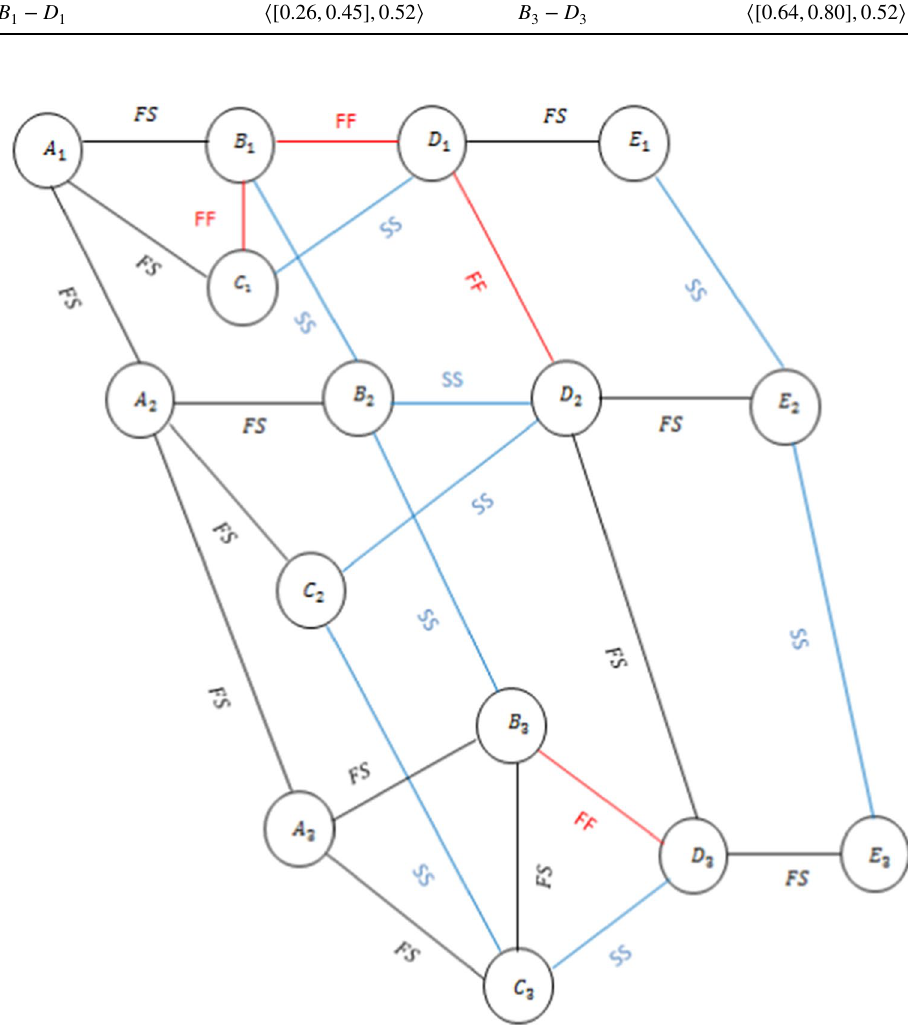
Table 6 The cubic fuzzy values of the relationships among activities relative to FF